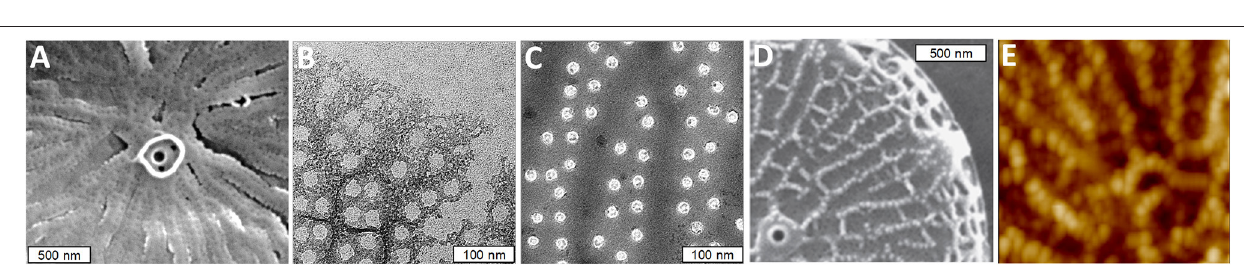
FIGURE 3 | Silica morphology during valve formation in T. pseudonana . (A) SEM of initially formed ribs and a precursor to the central fultoportula. (B) Network structure of initially deposited silica in the rib and pore area. (C) Mature pores, note circularity of the pores compared with (B) . (D) SEM of nanoparticles of silica on top of ribs on the distal valve surface. (E) Atomic force micrograph (AFM) of distal surface nanoparticles. From Hildebrand et al. (2006), reproduced with